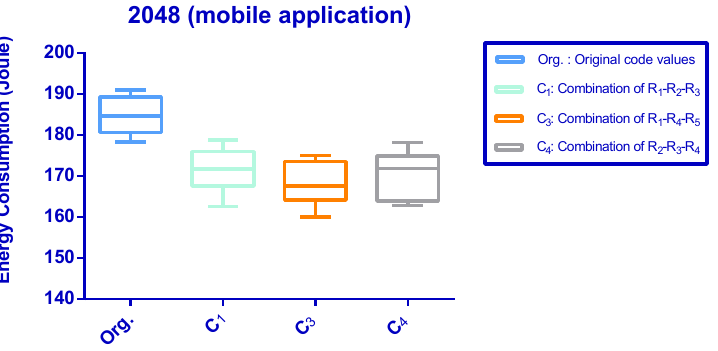
Figure 5. Boxplot of energy consumption results of original codes and combinations of refactoring techniques for the laptop dataset. Each dataset was measured 10 times. The x axis represents the name of each dataset and the y axis represents the energy consumption.